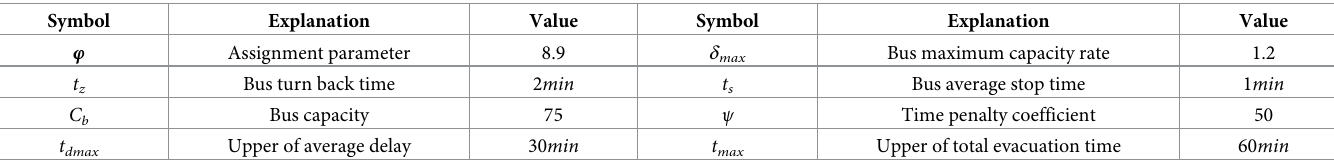
Table 1. The parameters of